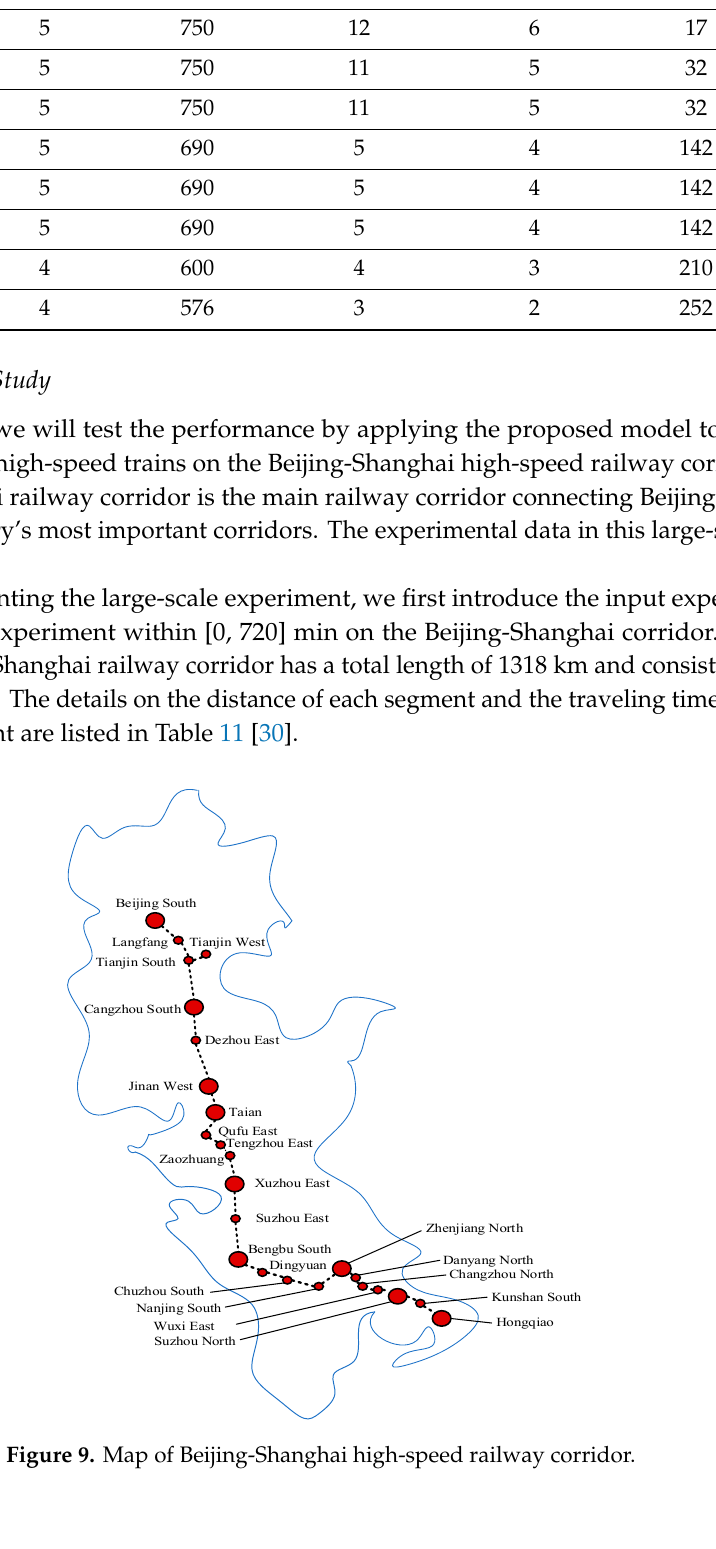
Table 10. Optimized solutions obtained under the minimum dwelling time y min .